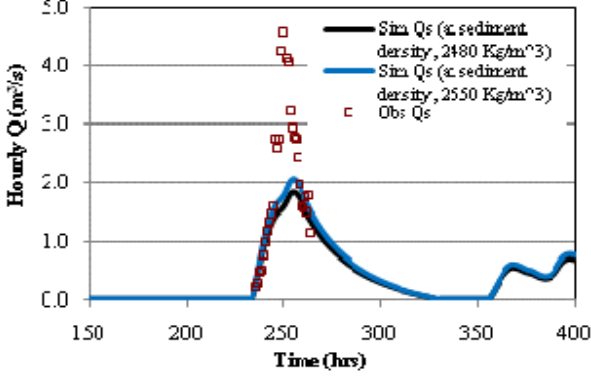
Fig. 13. Qs with different soil densities at Tateyama station.